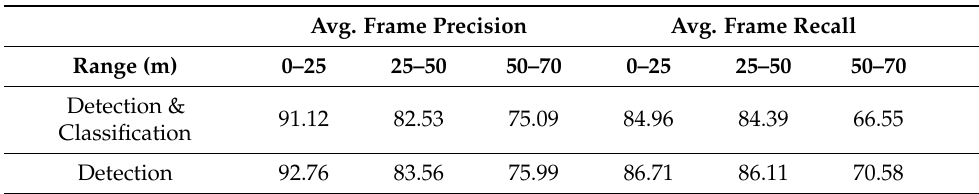
Table 4. Average Frame Precision and Recall results (%) at three different ranges, with and without taking into account the classification.